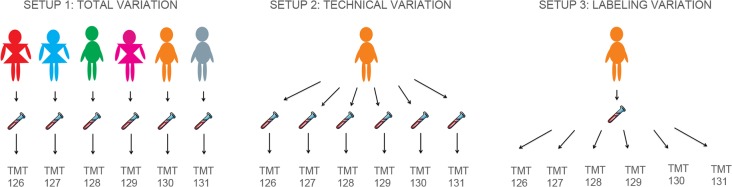
Overview of the experimental designs.Visualization of the three different set-ups in our variation study.